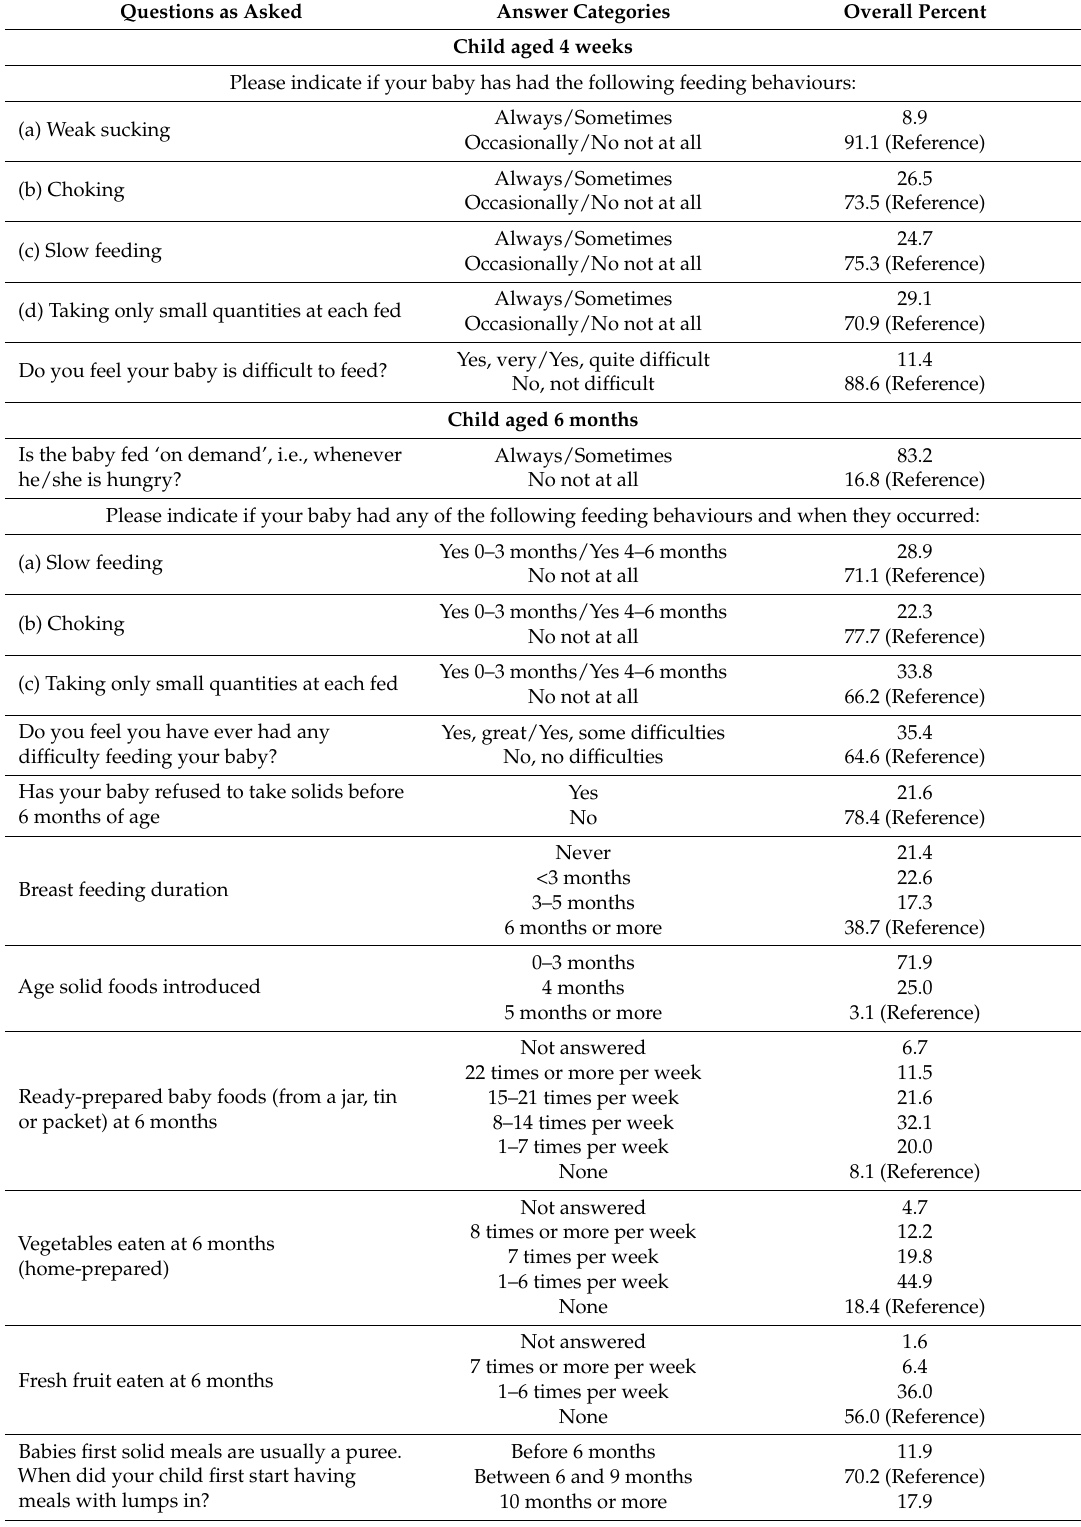
Table 1. Questions asked to parents, about feeding their child at different ages, together with the answer categories used in the regression models, grouped as shown for analysis, with frequency of occurrence in the whole